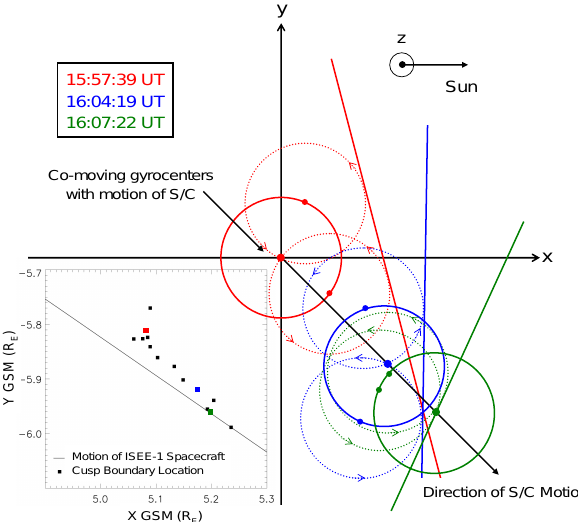
Fig. 8. An illustration of the evolution of the CEP boundary from 15:57–16:07 UT. The center of the gyroradii is assumed to be co- moving with the motion of the spacecraft. The boundary is initially roughly parallel to the direction the s/c is traveling, rotating about 60 ◦ in 3min so that the s/c penetrates the CEP boundary perpendic- ular. The inset plot on the lower left shows the GSM X-Y position of the satellite (solid line) and a projected evolution of the boundary location from the data presented in Fig. 7 (squares).